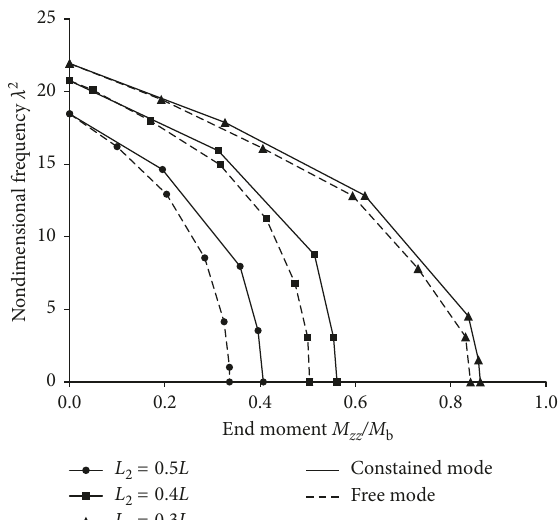
Figure 5: Fundamental natural frequencies ( λ 2 ) with respect to normalized applied end moment M zz / M b for both constrained and 0.5, P 0 / P cr 0.4, and different values of free modes with H 2 / H (cid:31) (cid:31) L 2 / L .